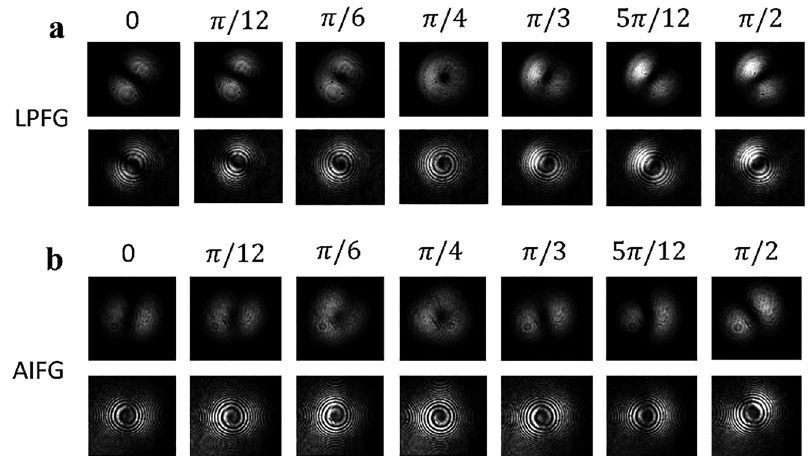
Figure4: Themode andreferencepatternsof OAMmodeoutputfor θ 1 from0to π /2based on (a) LPFG and (b)